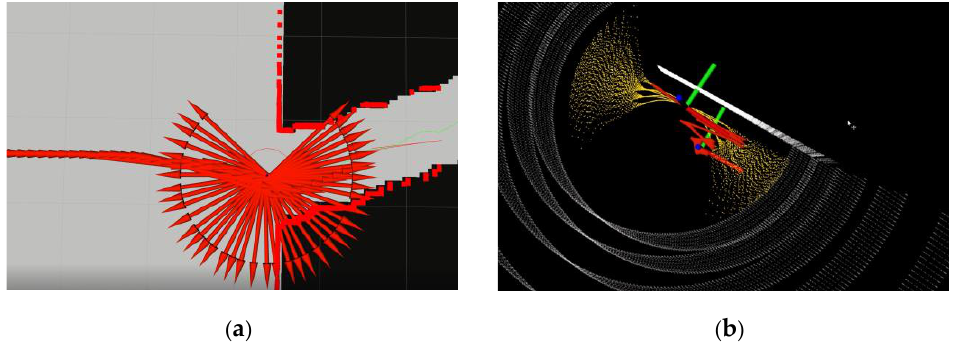
Figure 1. Oscillatory behavior of TEB and FALCO. ( a ) TEB in narrow channel; ( b ) FALCO in front of long obstruction.